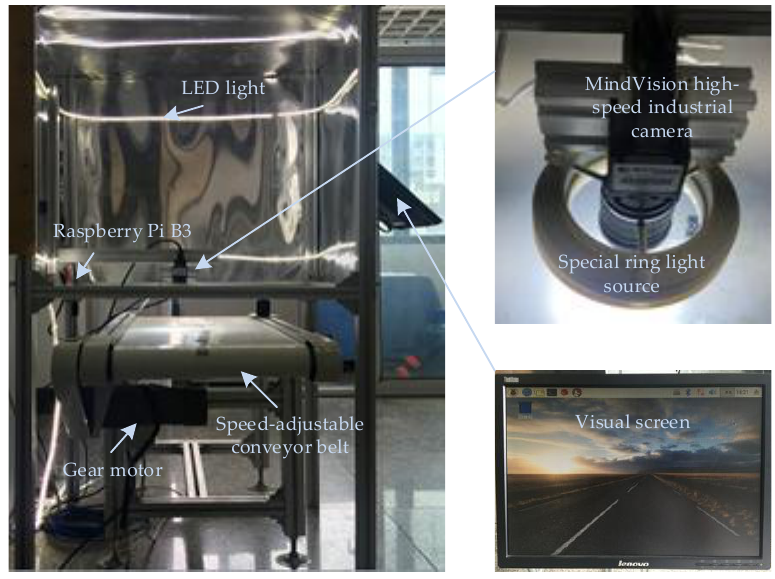
Figure 6. Experimental platform for real-time industrial object detection.